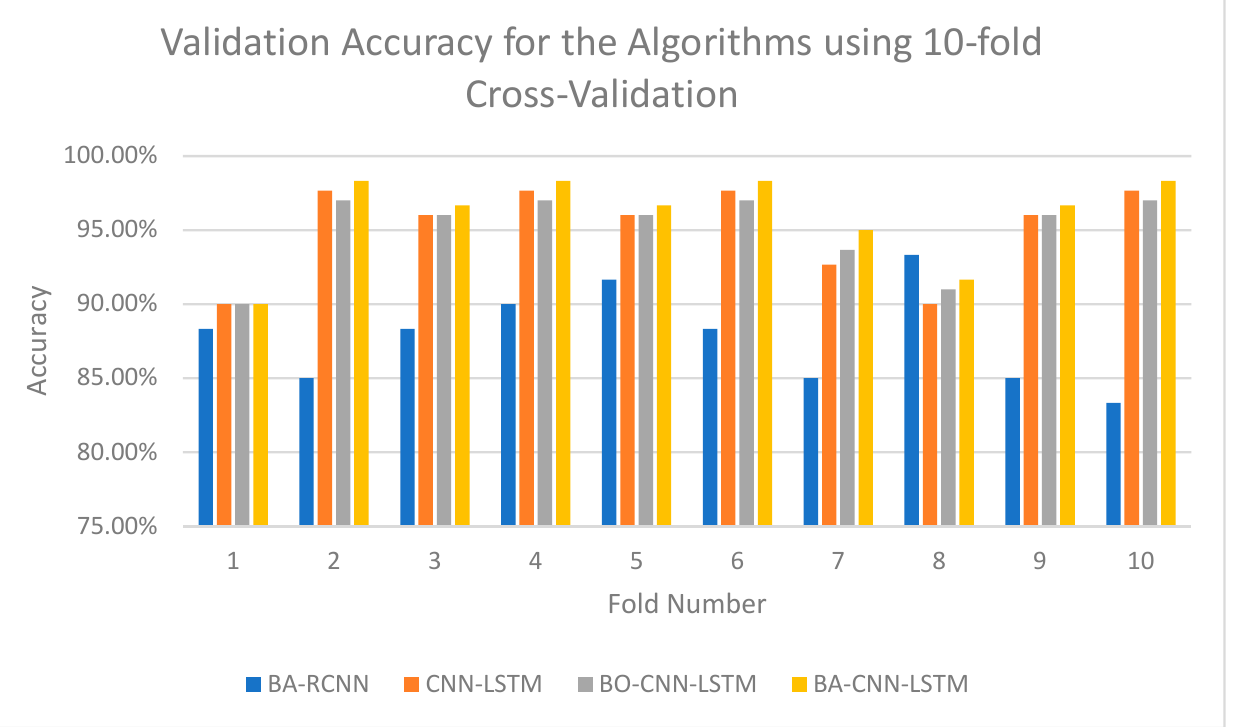
Figure 10. Validation accuracy for the algorithms using 10-fold cross-validation (artificial porosity images).